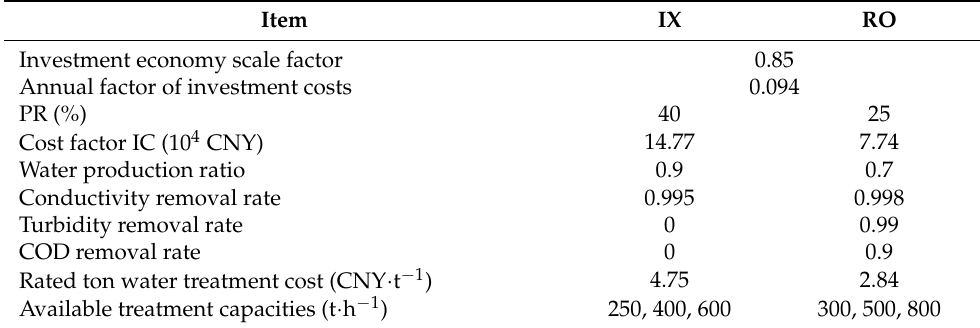
Table 1. Parameters related to desalination technologies.